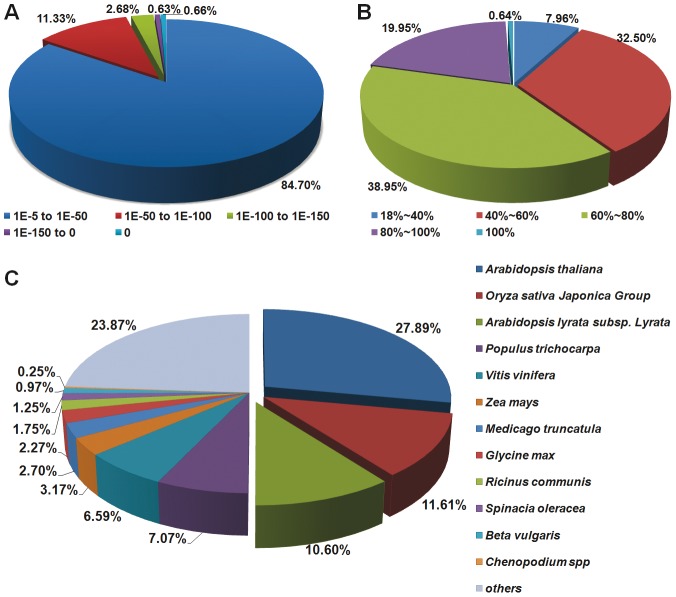
Characteristics of homology search of unigenes against the NR database.(A) E-value distribution of the top BLAST hits for each unigene with a cut-off E-value of 1.0E−5. (B) Similarity distribution of the best BLAST hits for each unigene. (C) Species distribution is shown as the percentage of the total homologous sequences with an E-value of at least 1.0E−5. We used all plant proteins in the NCBI NR database for homology search and extracted the first hit of each sequence for analysis.